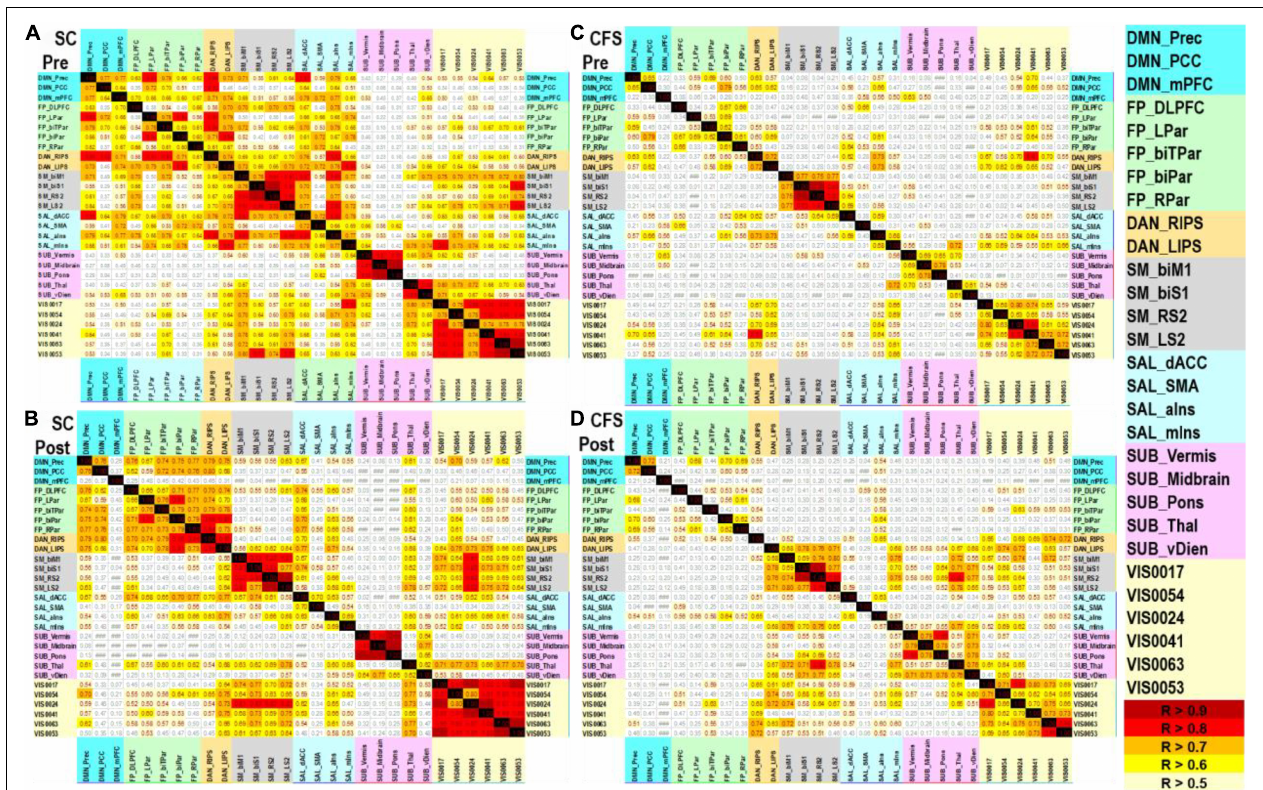
FIGURE 3 | Pearson correlation matrices. Age and gender regressed BOLD amplitude data were correlated for (A) sedentary control preexercise, (B) sedentary control postexercise, (C) CFS preexercise, and (D) CFS postexercise. Correlations are shown with R > 0.5 (light yellow), R > 0.6 (yellow), R > 0.7 (orange), R > 0.8 (red), and R > 0.9 (dark red) that were all p < 0.001 uncorrected. There were no significant negative correlations. Networks and nodes were highlighted in color on the right: DMN cyan, FPN green, DAN orange, SMN gray, SAL blue, SUB pink, and VIS